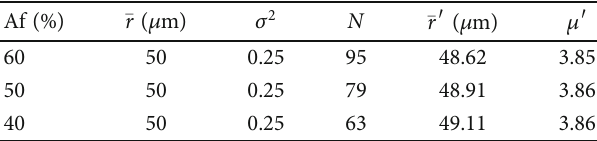
Table 1: Statistical parameters of the RVE